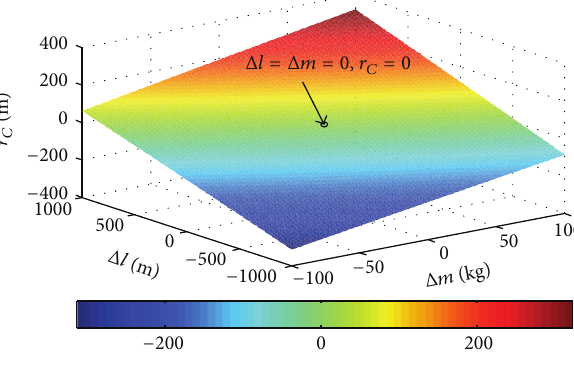
Figure 6: The COM deviation of MMET